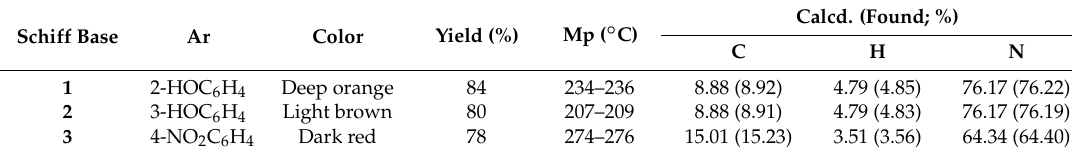
Table 1. Physical properties and elemental analyses for Schiff bases 1 − 3 .